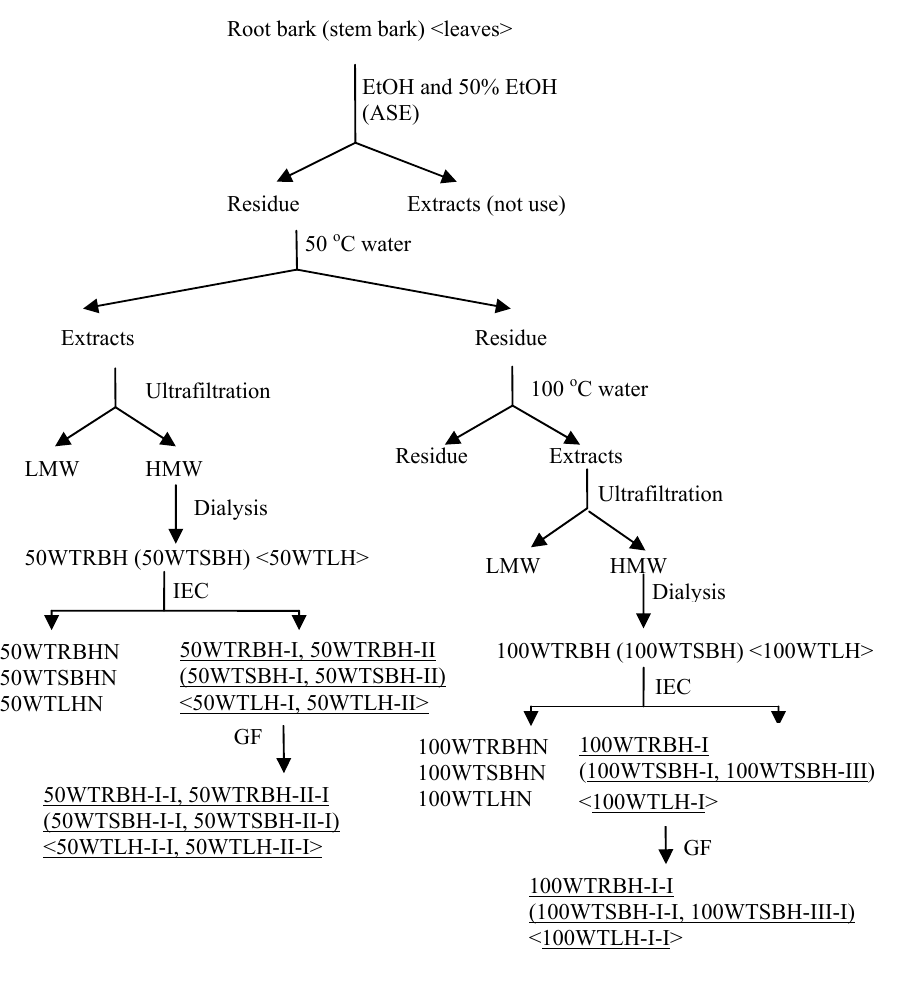
Figure 3. Extraction and fractionation scheme of polysaccharides extracted by accelerated solvent extraction (ASE) from root bark, stem bark and leaves of T. macroptera (IEC, ion exchange chromatography; GF, gel filtration; underlined acidic fractions showed high complement fixation activity and were fractionated for further